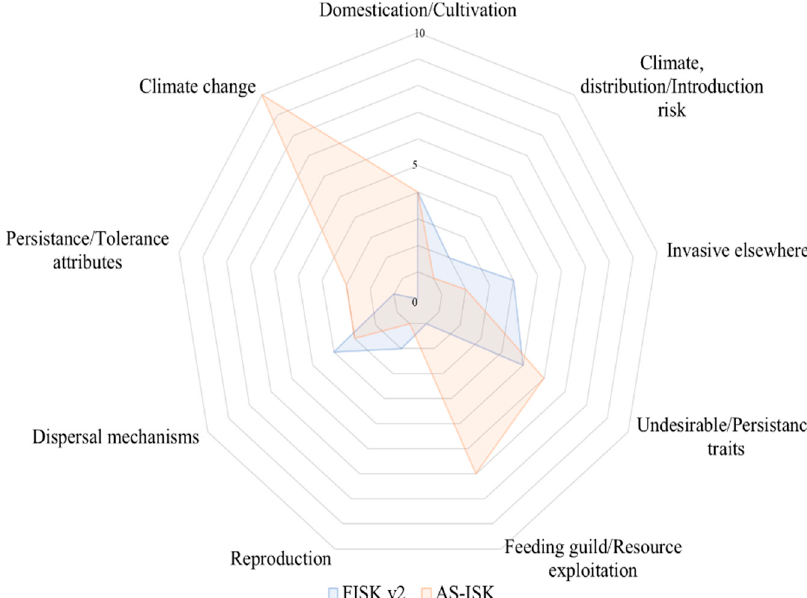
Figure 4. Radar plot showing the scores achieved by A. facetus in each attribute upon the application of the two different risk assessment kits FISK v2 (in light blue) or AS-ISK (in light orange) for Portugal. The latter takes into account the possible advantages of the species in climate-change scenarios, a parameter not considered in FISK v2.